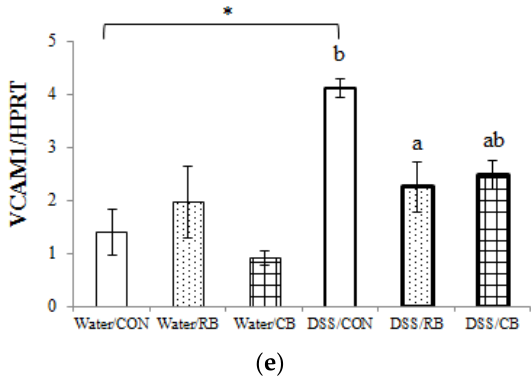
Figure 5. The effect of diet and dextran sulfate sodium (DSS) on mRNA expression of pro-inflammatory cytokines: ( a ) normalized expression of IL1β; ( b ) normalized expression of IL6; ( c ) normalized expression of CCL2; ( d ) normalized expression of CCR2; and ( e ) normalized expression of VCAM-1. Diet groups are tap water and control (Water/CON), tap water and 10% raw broccoli (Water/RB), tap water and 10% lightly cooked broccoli (Water/CB), DSS and control (DSS/CON), DSS and 10% raw broccoli (DSS/RB), and DSS and 10% lightly cooked broccoli (DSS/CB). Data are mean ± SE, n = 3, except for DSS/RB ( n = 4). *, ** and *** indicate significant effect of DSS ( p < 0.05, p < 0.01 and p < 0.001, respectively). The presence of letters indicates a significant effect of diet within Water groups or DSS groups ( p < 0.05). Values with the same letter are not different ( p < 0.05).